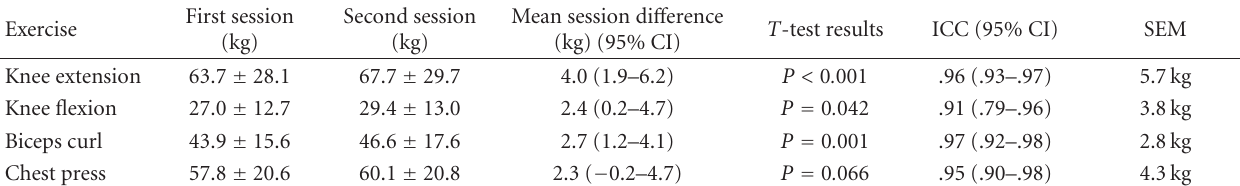
Table 2: One-repetition maximum test results. The session 1-RM values are presented as mean ± standard deviation.